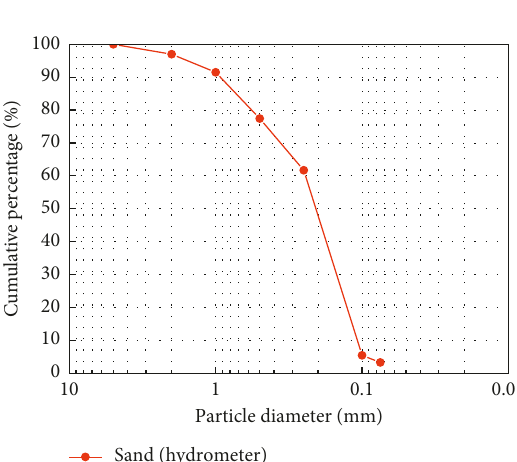
Figure 1: Particle-size distribution of Table 3: Summary of triaxial test results.